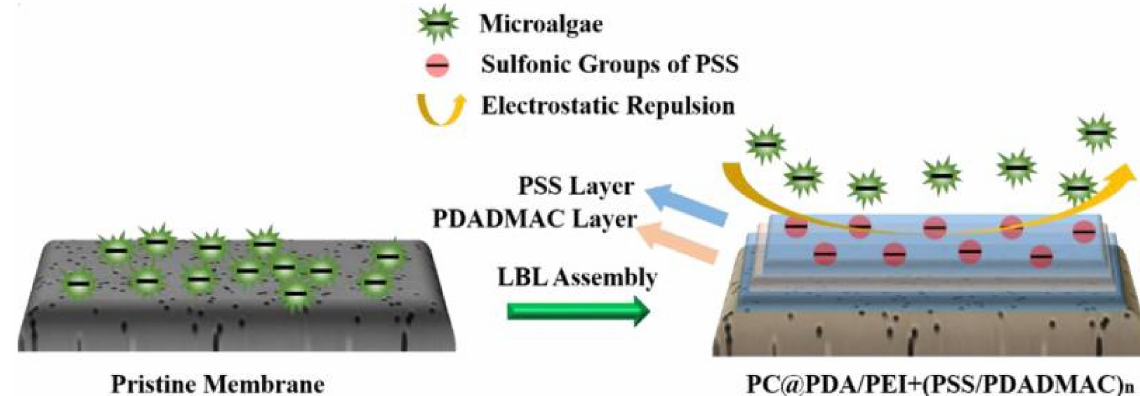
Figure 4. Schematic illustration comparing the antifouling mechanism of a neutrally charged pristine polycarbonate (PC) membrane and a charged and hydrophilic PC membrane fabricated using the layer-by-layer (LBL) self-assembly technique with polydopamine (PDA) and polyethylenimine (PEI) coating and further uniform assembling of poly-(styrenesulfonate) (PSS) and poly-(diallyldimethylammonium chloride) (PDADMAC) via electrostatic attraction. The cell surface charge of most microalgae is (slightly) negative [36]. Reprinted with permission from Huang et al. [78], Copyright 2020, with permission from